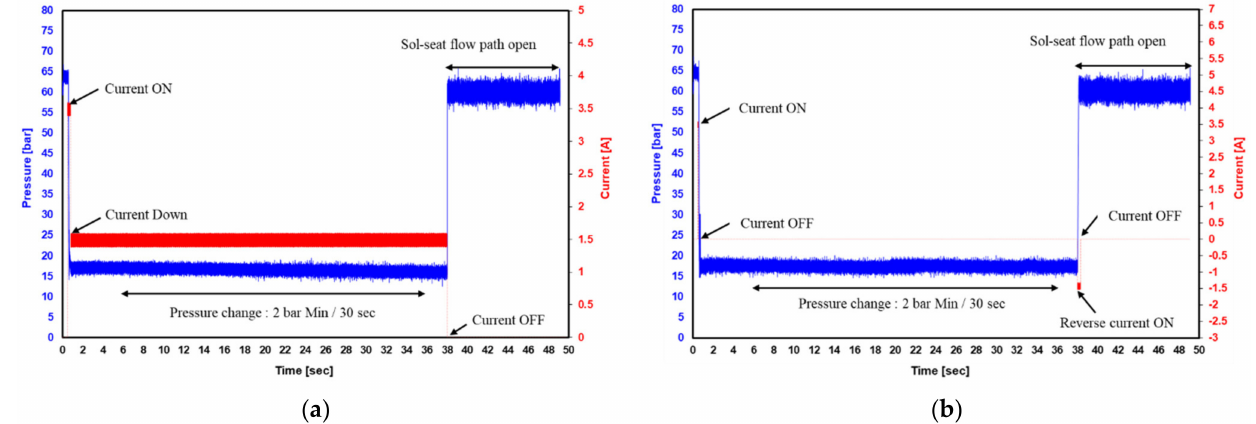
Figure 21. Comparisons of function tester results: ( a ) conventional TCV; ( b ) permanent magnet